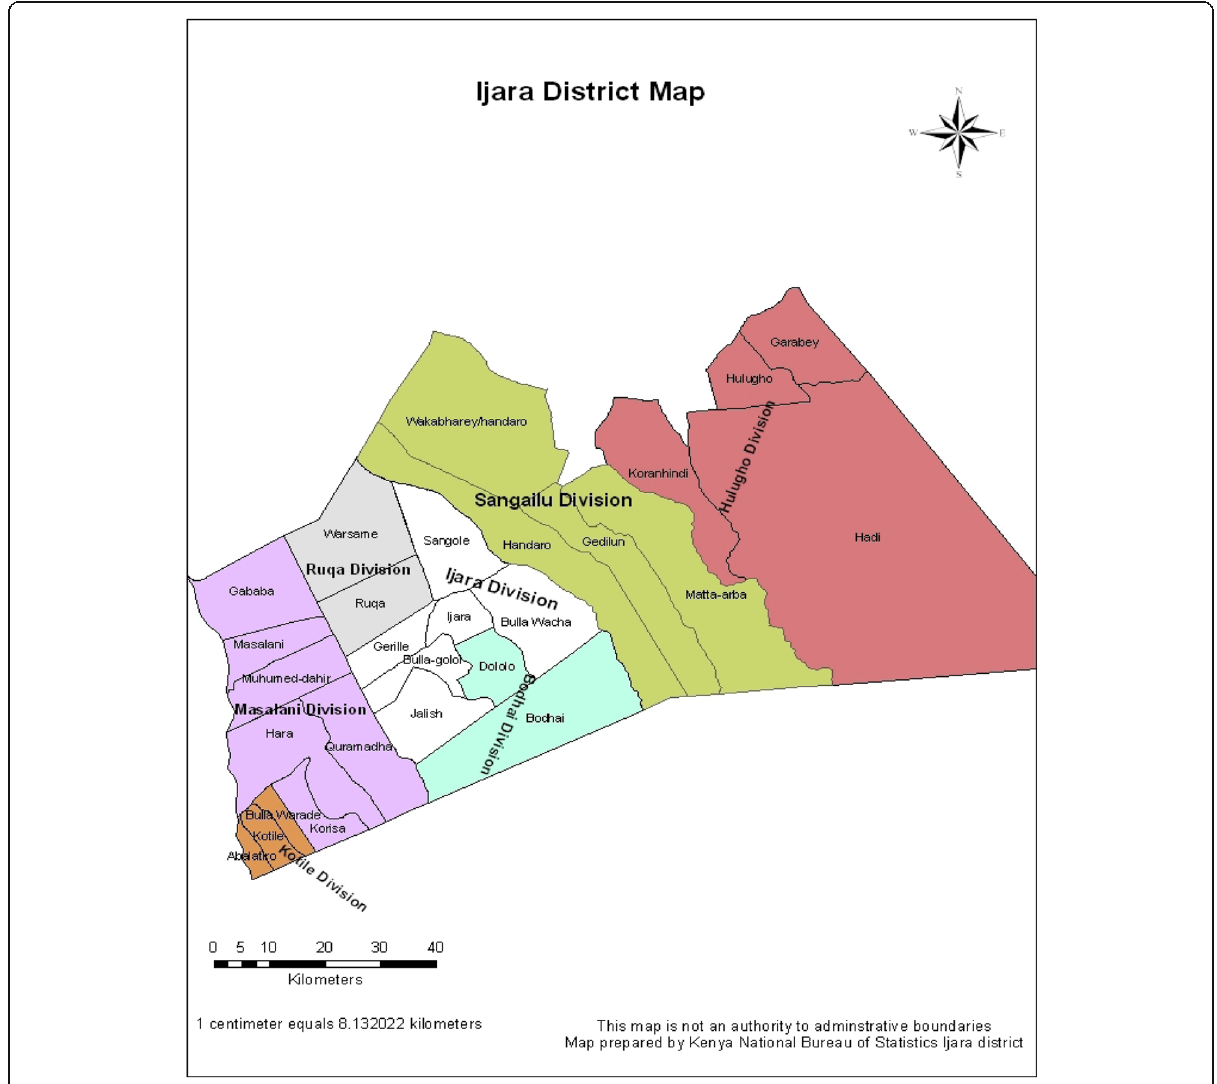
Fig. 1 Map of Ijara sub-county. Source: Mburu et al.